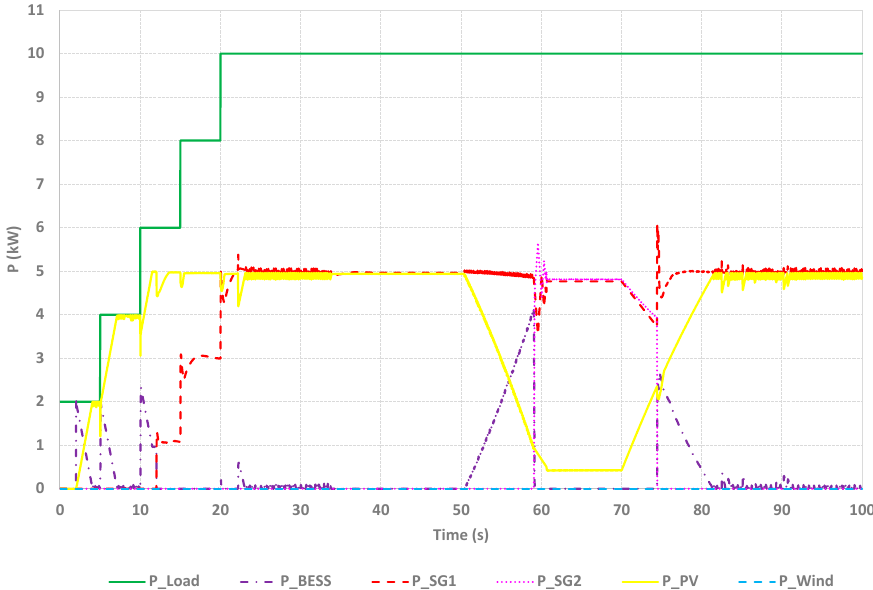
Figure 16. Scenario 4b: Cloud transient analysis for maximum solar PV generation and zero wind generation for a 10 kW demand with the BESS.